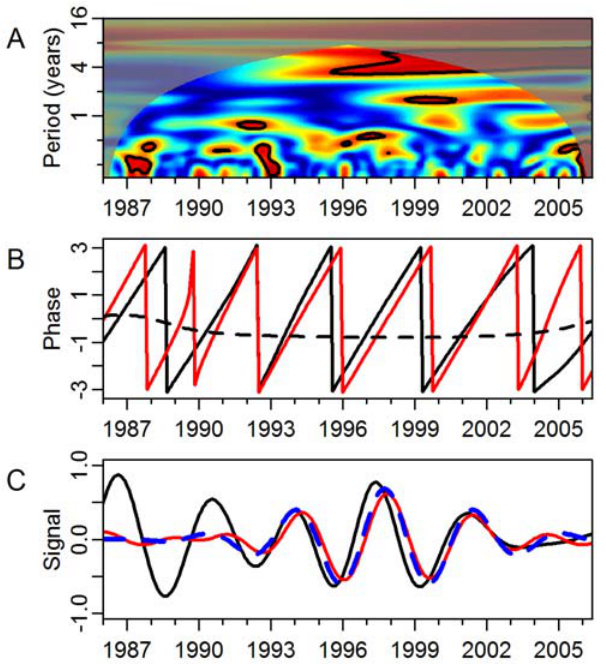
Figure 2. Coherence between ENSO and dengue in Puerto Rico. (A) Squared coherence plot of dengue incidence in Puerto Rico and ENSO. Coherence increases from blue to red. Areas where coherence is significantly high (95% confidence level) are encircled by black lines. Shaded areas indicate the presence of edge effects. (B) Phase of ENSO (solid black) and dengue incidence (red) and phase difference (dashed black) at a periodicity of 3–4.5 y. (C) Reconstructed ENSO (black) and dengue incidence (red) at a periodicity of 3–4.5 y. A similarly scaled Morlet wavelet is superimposed (blue).